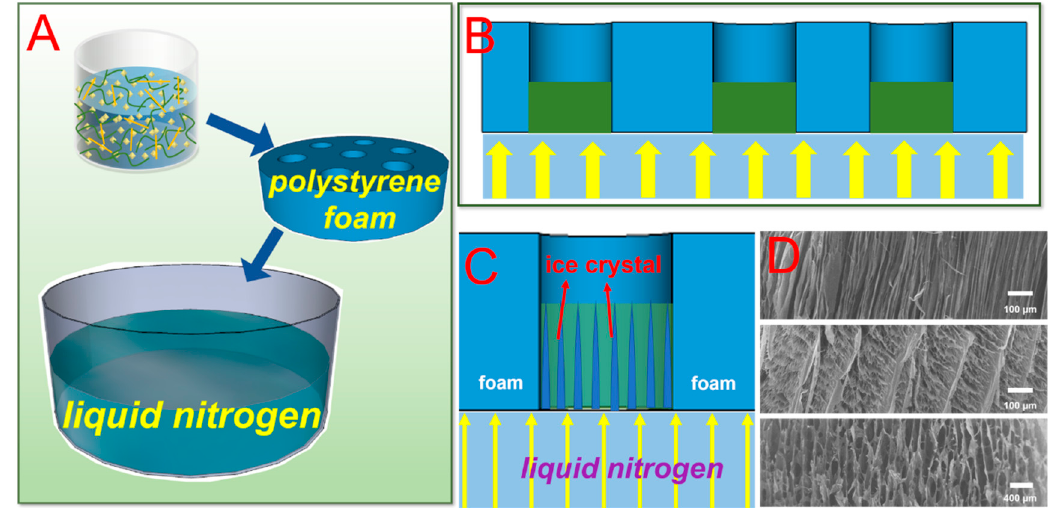
Figure 2. ( A – C ) The experimental process of directional freeze-drying. ( D ) Morphology of the U -EDTA CCA via directional freeze-drying.